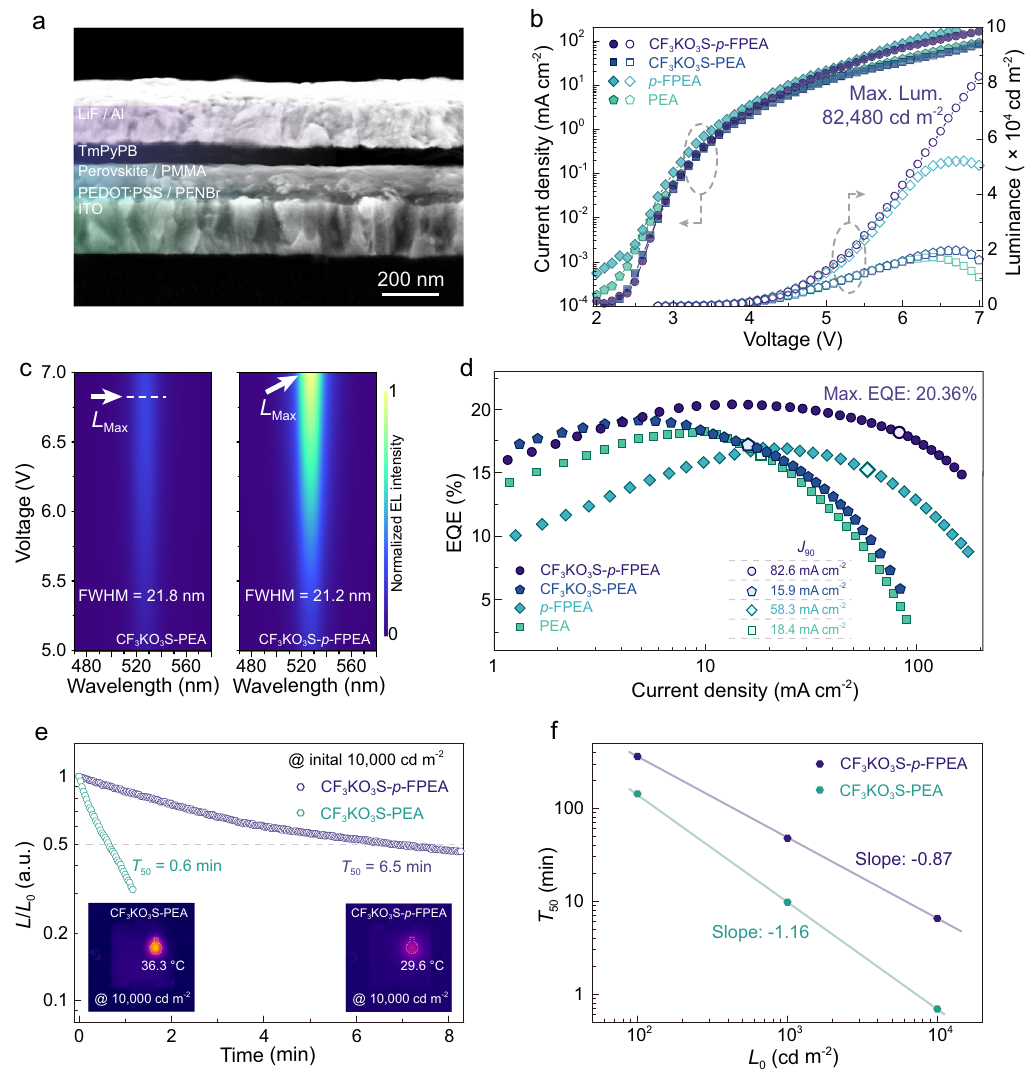
Fig. 4 Device performance of the resulting PeLEDs. a Cross-section SEM image for CF 3 KO 3 S- p -FPEA PeLEDs. b I – V and L – V curves for PeLEDs based on different quasi-2D perovskites. c EL spectra as a function of voltage for CF 3 KO 3 S-PEA and CF 3 KO 3 S- p -FPEA PeLEDs. d Current density-dependent EQE curve for different quasi-2D PeLEDs. e Half-lifetime ( T 50 ) measurements and corresponding spatial surface temperature for PeLEDs at an initial luminance of 10,000cd m − 2 . f Half-lifetime ( T 50 ) of PeLEDs at different initial